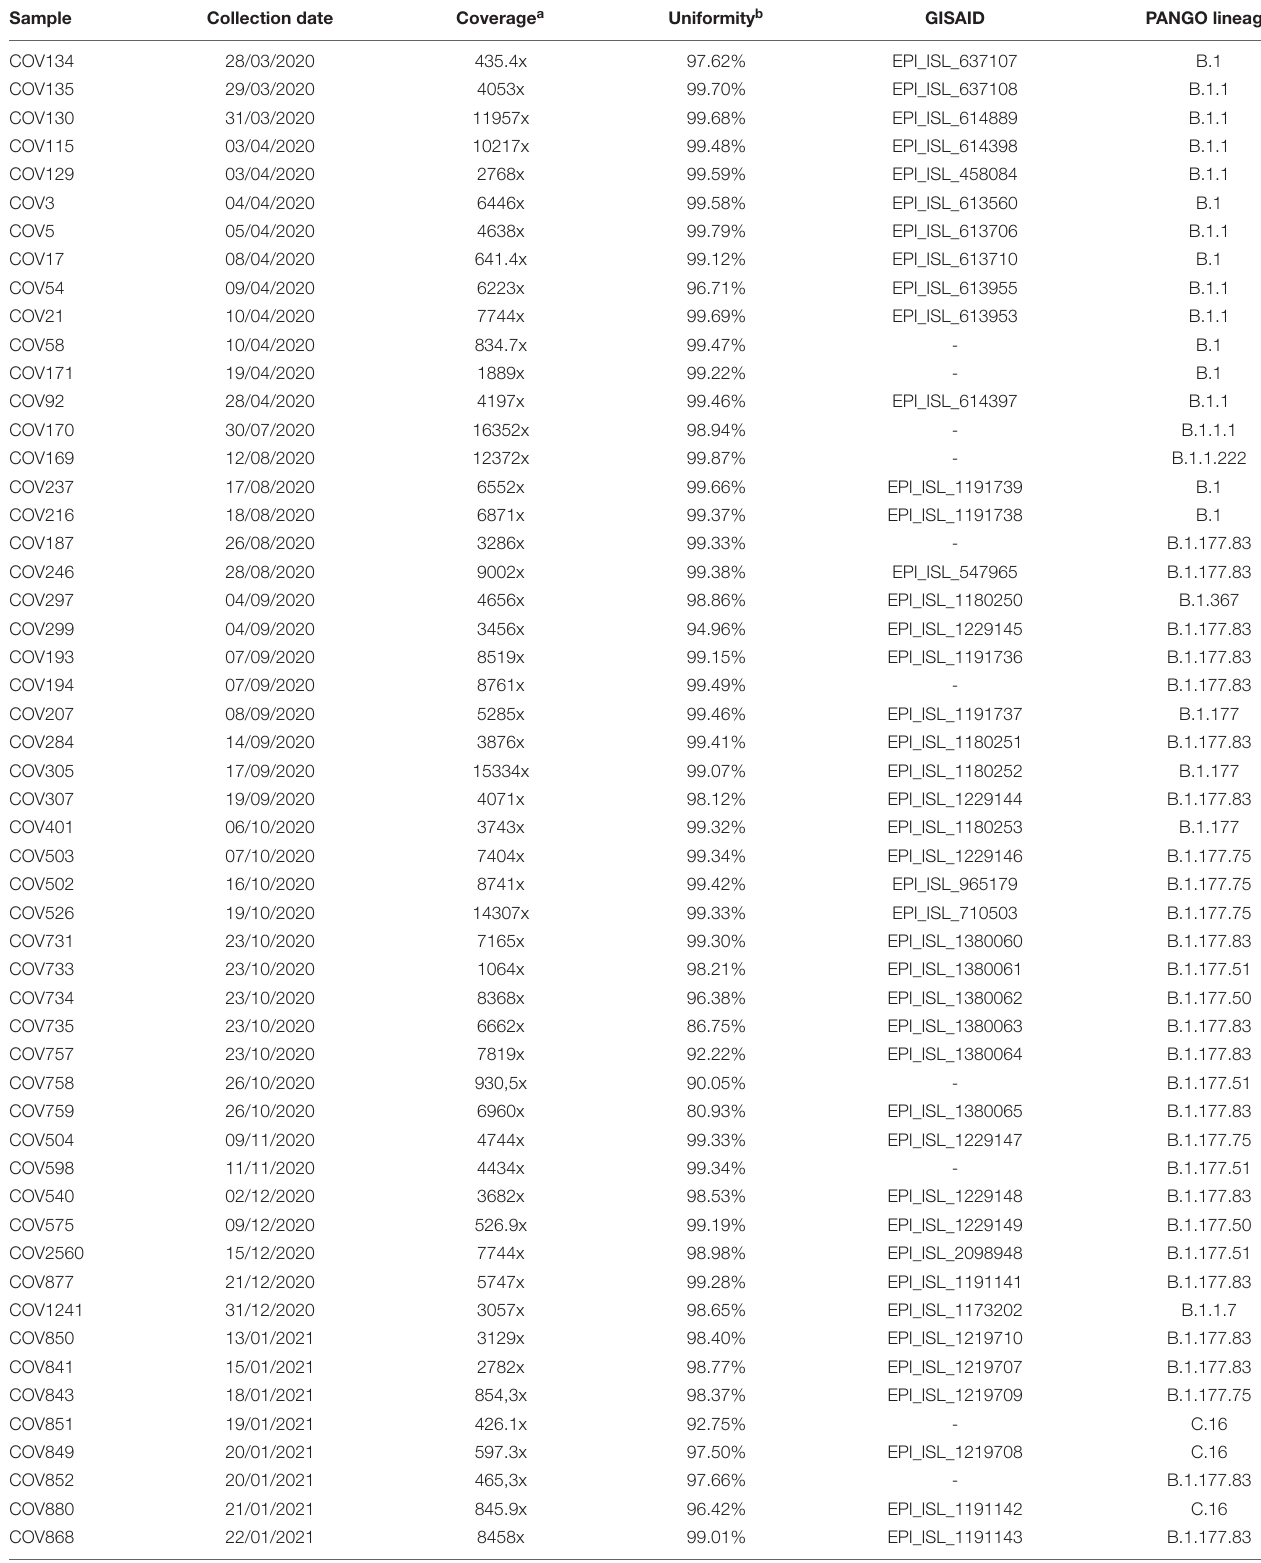
TABLE 1 | Dataset of 92 Nuoro SARS-CoV-2 sequences.